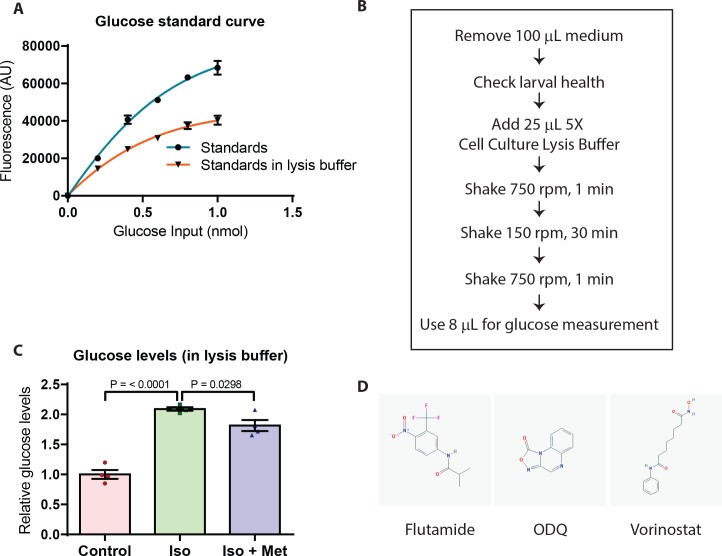
A 96-well plate-adapted protocol to measure glucose levels is suitable for small molecule screening.(A) Plotting the measured glucose levels interpolated from the regular standard curve (blue) shows a shifted curve in the presence of lysis buffer (orange) with a dynamic range still suitable for measuring glucose levels. (B) Schematic showing the plate-adapted glucose readout assay. (C) Relative free glucose levels upon treatment of wild-type larvae from 4 to 6 dpf with the beta-adrenergic agonist isoprenaline (Iso) or both isoprenaline and metformin (Iso +Met); mean ± SEM, n = 4–5 replicates. (D) Structures of the hits - flutamide, ODQ and vorinostat. P values from t-tests.